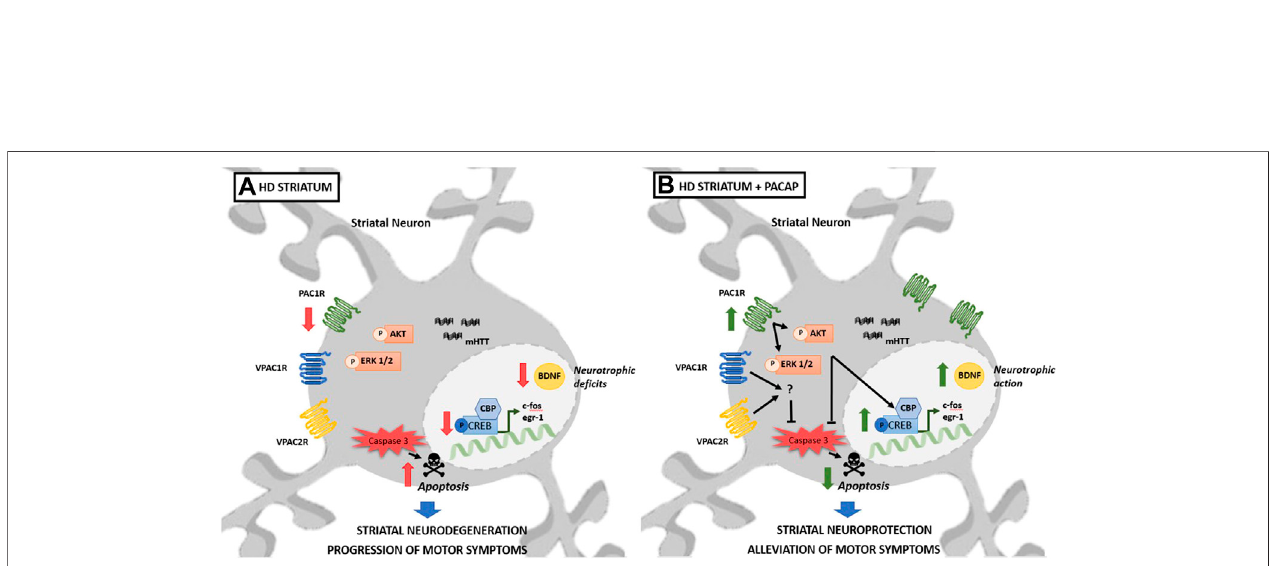
FIGURE 12 | Proposed mechanisms by which PACAP protects striatal neurons from mHtt toxicity and performs motor function. (A) HD striatum: striatal neurons expressing mHtt exhibit diminished protein levels of PAC1R from the onset of motor symptoms, without changes in VPAC1R and VPAC2R. The decrease of PAC1R is associated with the reduction of early genes and CBP and with the downregulation of BDNF conducing to cell death and neurotrophic de fi cits leading to motor discoordination. (B) HDstriatum+PACAP:PACAPadministrationprotectsstriatalcellsandenhancesmotorfunction.Theseeffectsareassociatedtotheincrease inPAC1R,tothephosphorylationofERKandAktandtotheenhancedexpressionofearlygenes,CBPandBDNF.AlthoughactivationofVPAC1RandVPAC2Rprotects striatal cells from mHtt-induced toxicity, the activation of PAC1R is crucial to induce the antiapoptotic and neurotrophic effect of PACAP through the activation of described signaling.